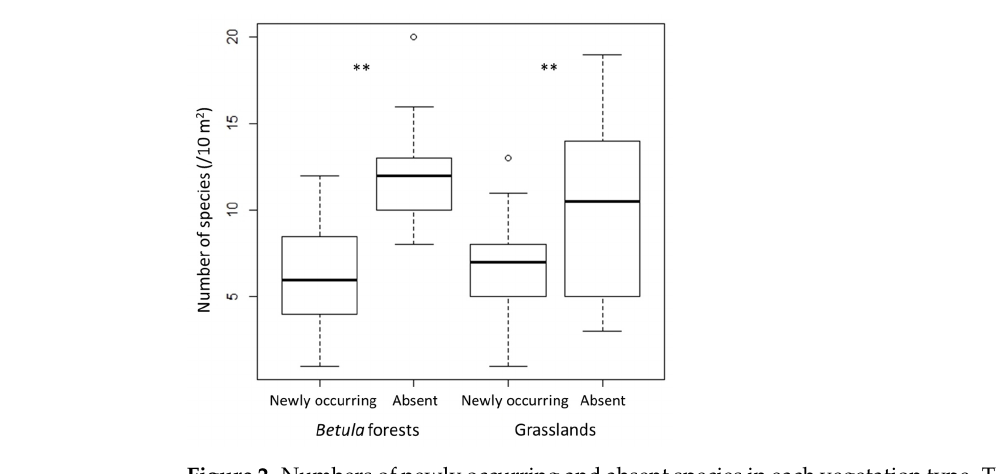
forests indicated that the occurrence frequencies of species in the Betula forests were similar in both 2010 and 2018. Species composition differed significantly between vegetation types in both censuses ( p < 0.01, Table S1).